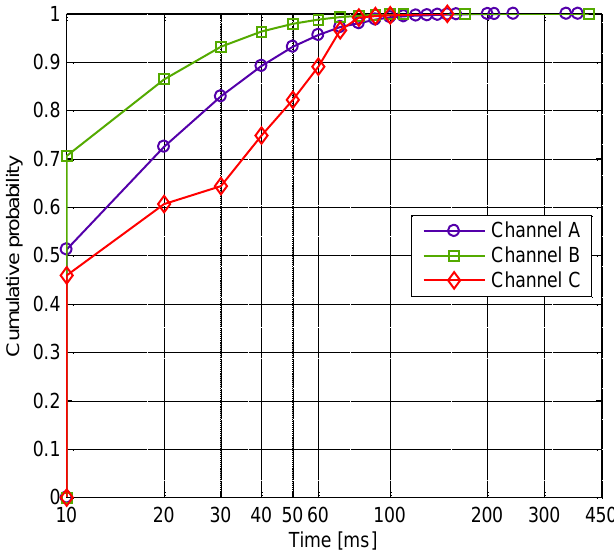
Figure 7. CDF for the bad channel fade